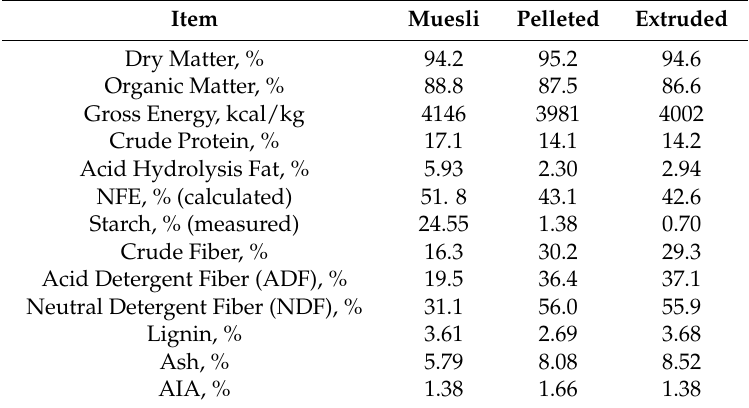
Table 1. Nutritional composition (DM basis) of muesli, pelleted, and extruded diets consumed by groups of five rabbits (15 total) during the 30-day experiment.